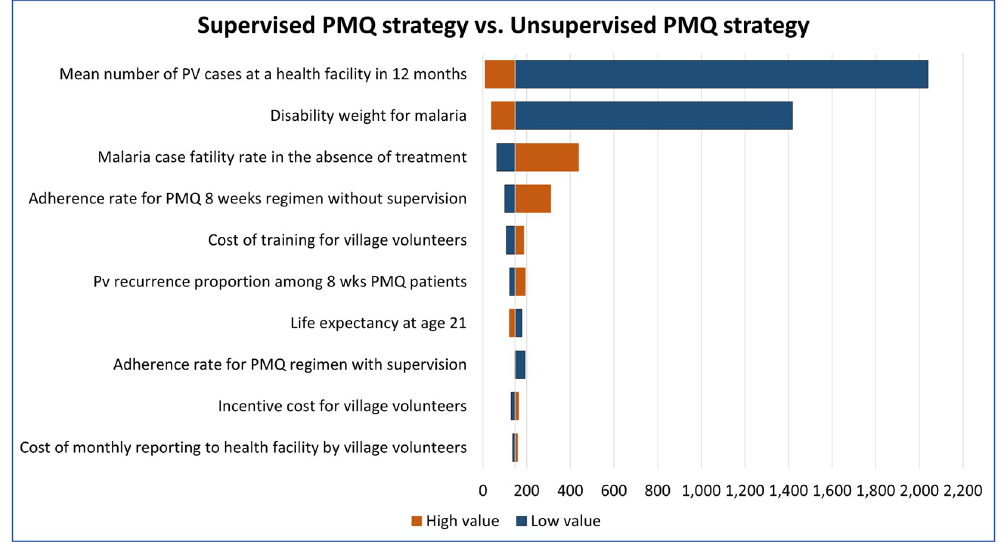
Fig 10. Deterministic one-way sensitivity analysis for supervised PMQ strategy against unsupervised PMQ strategy. The vertical central line represents the base case ICER.